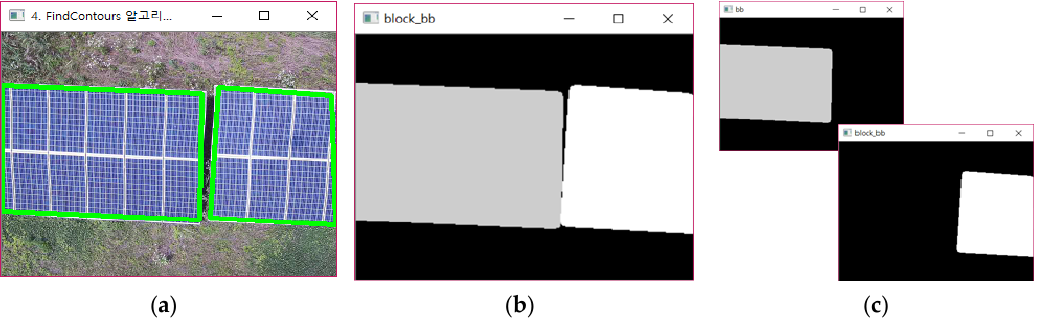
Figure 7. Block segmentation through findcontours: ( a ) find contours; ( b ) mask image; ( c ) sub-block mask image.